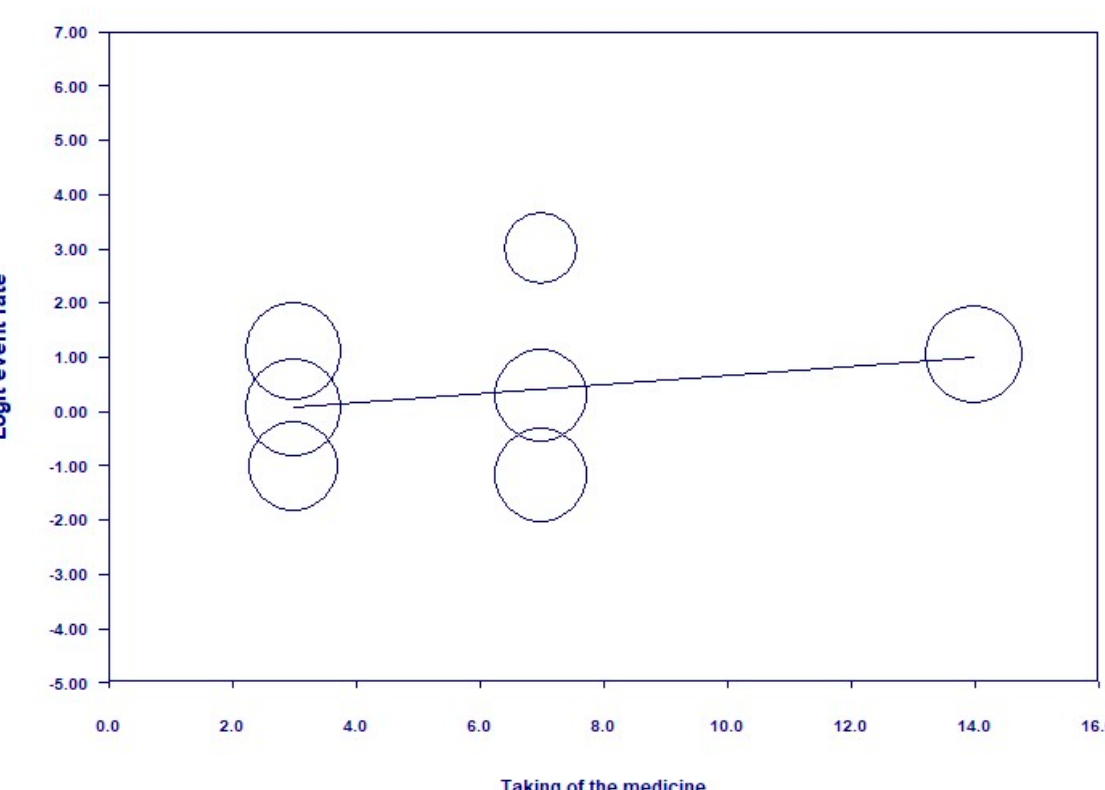
Figure 3. Logit regression on the correlation between the recombinant human epidermal growth factor (rhEGF) application frequency (horizontal axis—measured in weeks) and complete healing rate.